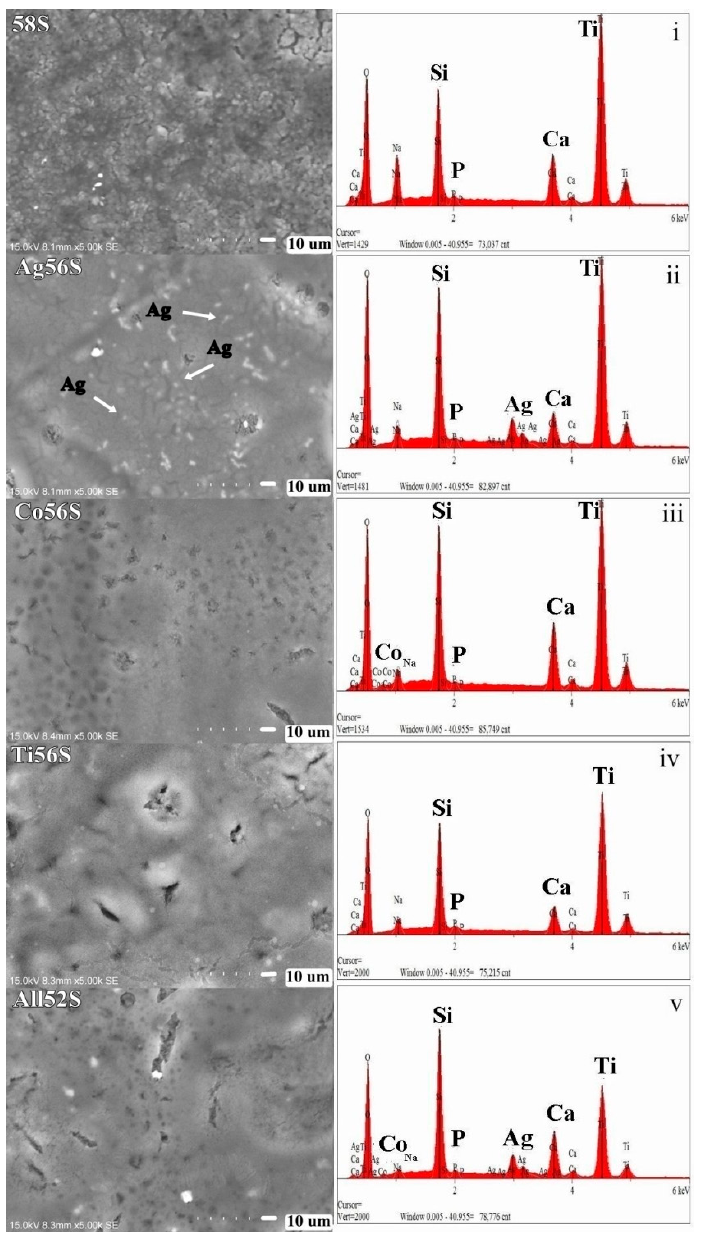
Figure 1. SEM micrographs (5000×) and EDX spectra of different bioactive glass coatings: i. 58S, ii. Ag56S, iii. Co5S, iv. Ti56S and v. All52S. The arrows indicate the “Ag” particles. Table 2. Nanohardness of the bioactive glass